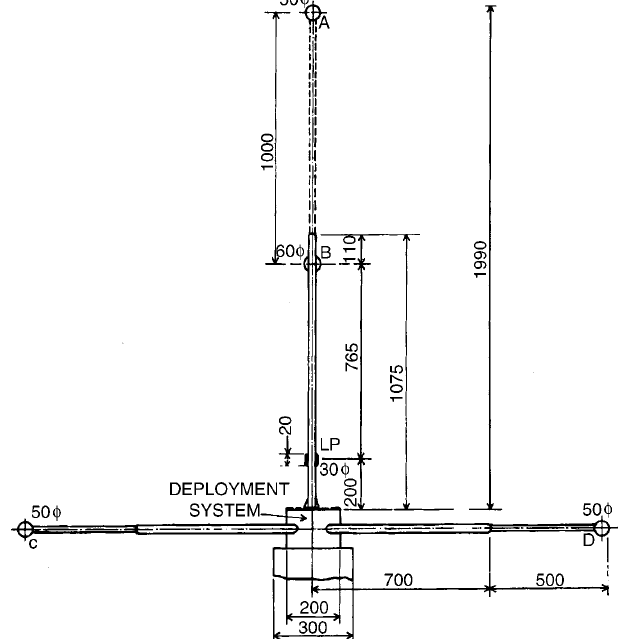
Fig. 1. Geometry of Langmuir probe and electric field sensors flown on the RH-560 rocket from